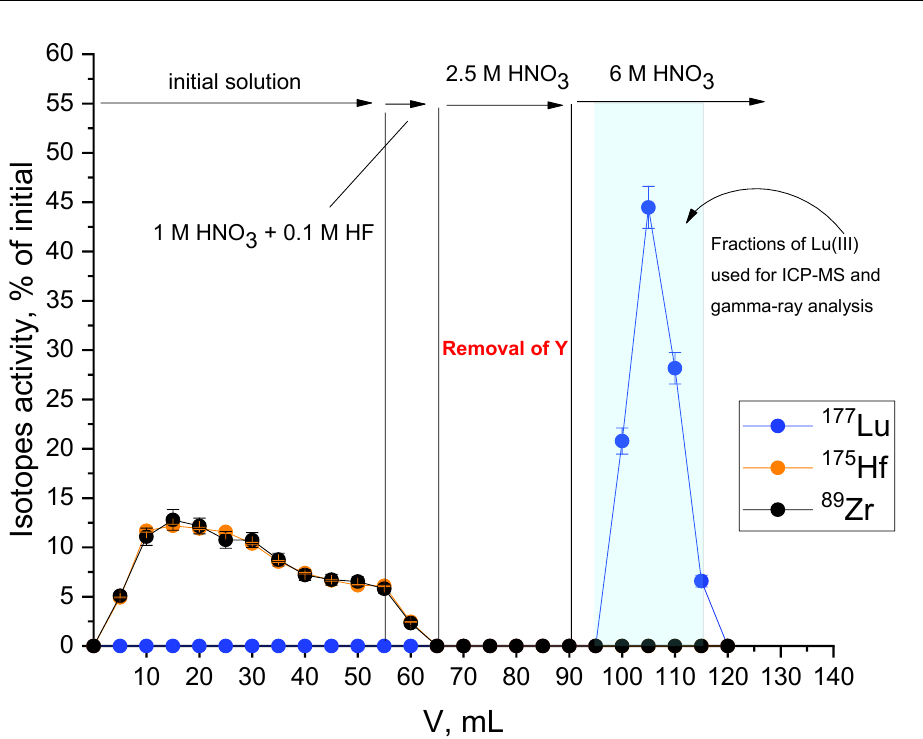
Table 1. Quantities of 177 Lu and other elements in eluate during different stages of 177 Lu recovery. Content of Elements in Eluate, % of Initial Stage Hf Zr Y Lu Sorption of 177 Lu onto the column, rinsing 100 100 40 <2 with the mixture of 1 M HNO 3 and 0.1 M HF Rinsing with 2.5 M HNO 3 0 0 60 0 Desorption of 177 Lu with 6 M HNO 3 0